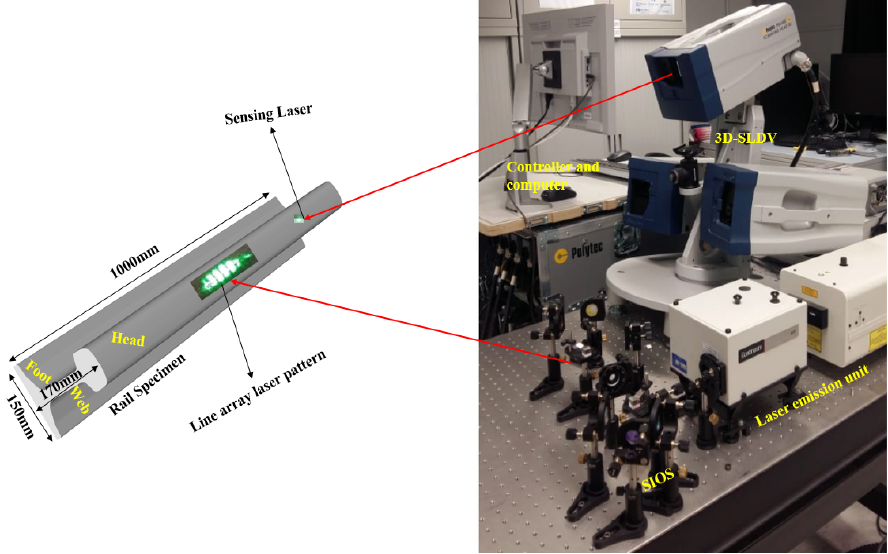
Figure 4. Schematic illustration of the experimental setup for non-contact